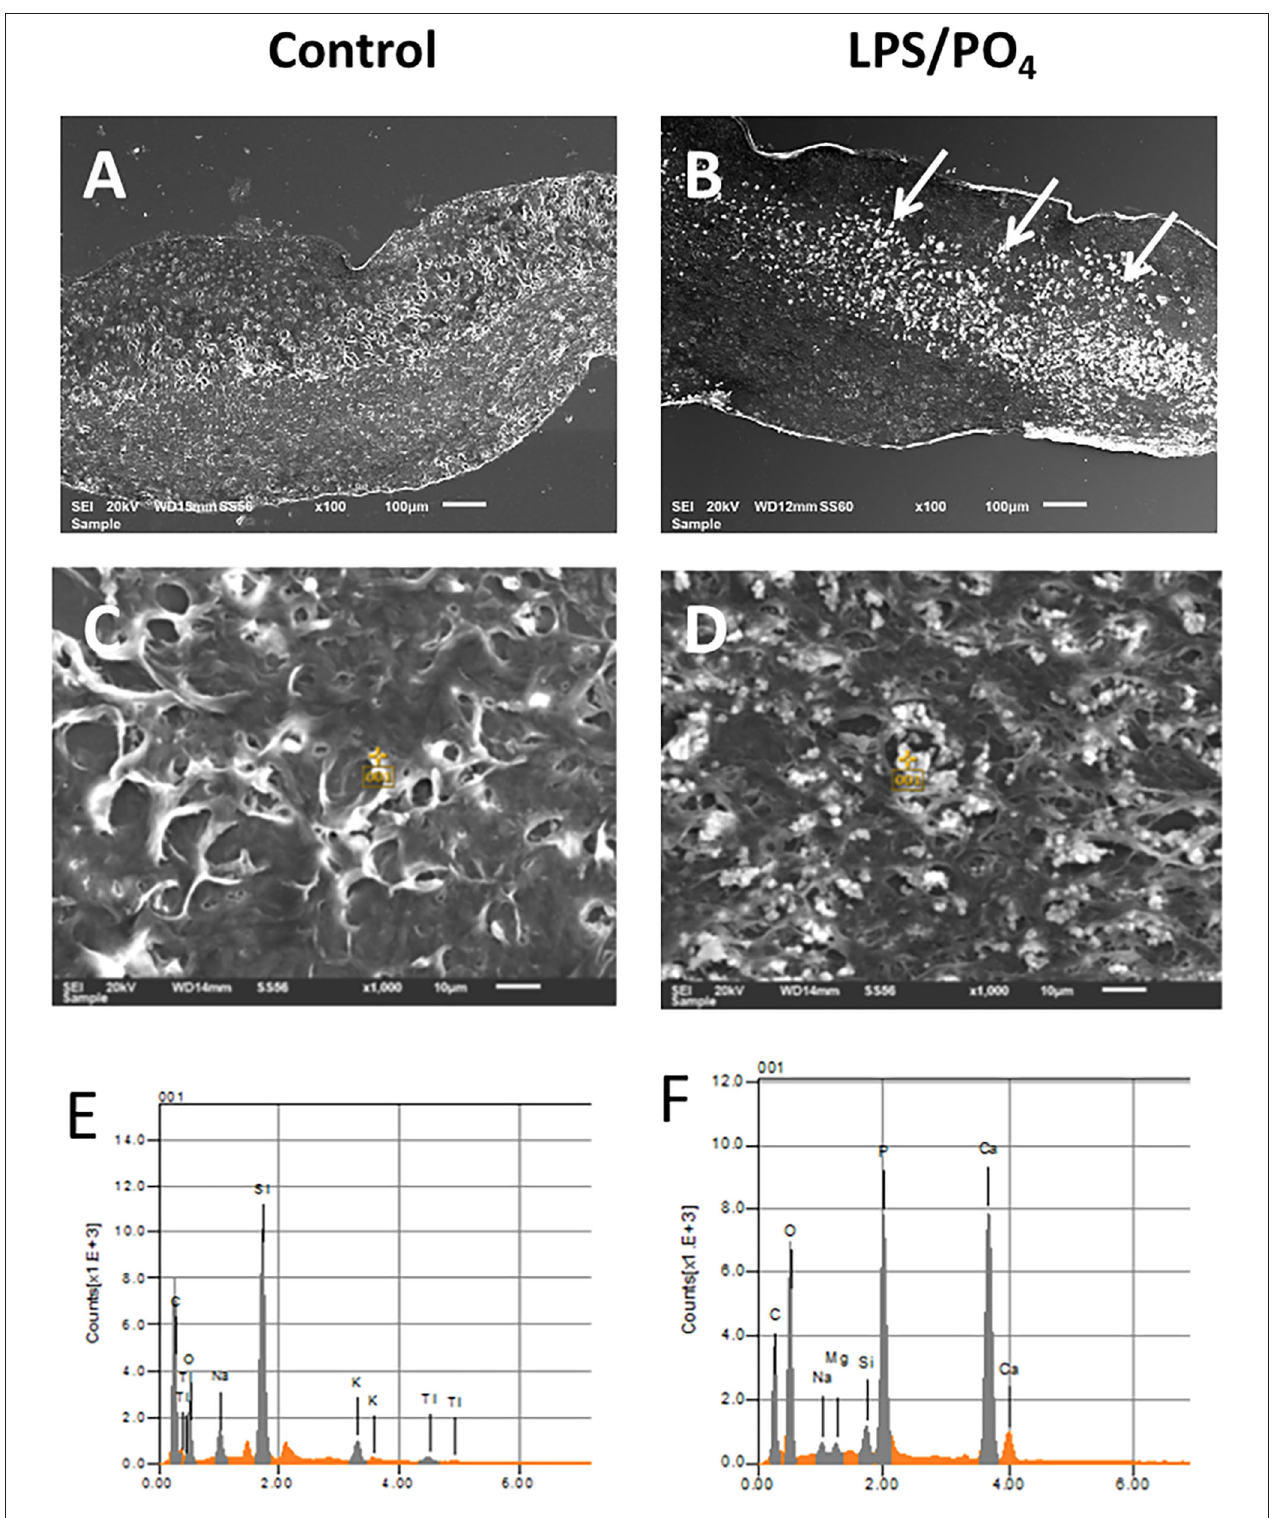
FIGURE 4 | Electron microscopy and EDAX analysis of calcified valve leaflets. Scanning electron micrographs of porcine valve leaflets stimulated with media alone (A) or 100ng/mL LPS and 3mM phosphate for 14-days (B) , with presence of calcified areas (white arrows) (x100 magnification, scale bar = 100 µ M). High power view and point analysis (yellow cross) of aortic valve leaflets from control and LPS/PO4 treated valves (x1,000 magnification, scale bar = 10 µ M) (C,D) , and the spectrum showing no calcium or phosphorus peaks in the control (E) , but their presence in the LPS/PO4 treated tissue (F) .